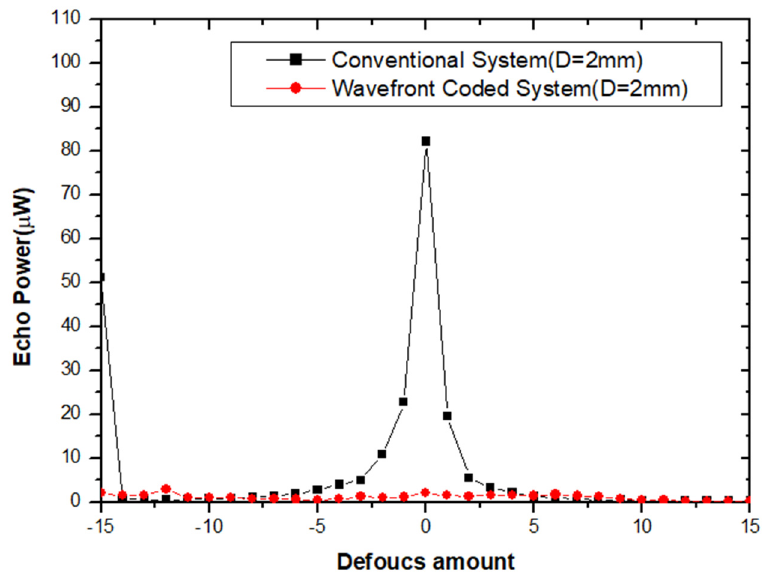
Figure 9. Comparison of the power of cat-eye echo in conventional and wavefront coded imaging system.